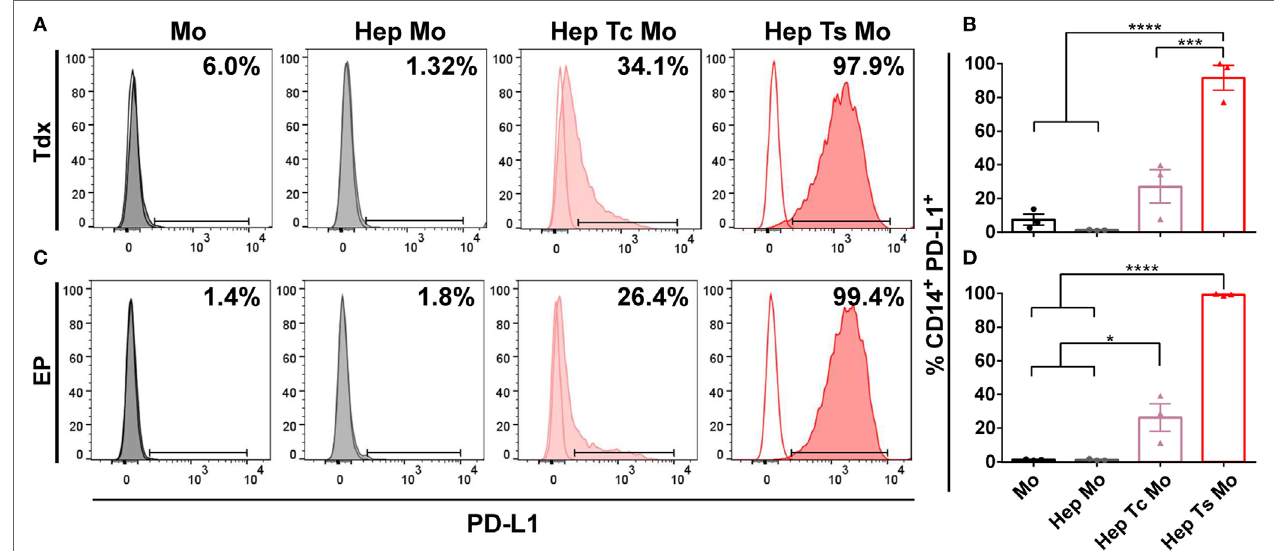
FigUre 3 | (a,c) Representative histograms of the flow cytometry data of CD14 + PD-L1 + monocytes for co-cultures with either Tdx (a) or EP (c) HBV-specific TCR T cells at 24 h are shown. Tinted and non-tinted histograms, respectively, represent the stained sample or matched isotype control, where a horizontal line is drawn based on the isotype control to demarcate for PD-L1 + cells. Percentage values of CD14 + PD-L1 + cells are indicated. (B,D) Bar plots show the mean ± SEM of PD-L1 + monocytes for co-cultures involving Tdx (B) or EP (D) HBV-specific TCR T cells; bars are drawn where a comparison was made with * P ≤ 0.05, *** P ≤ 0.001, and **** P ≤ 0.0001. Statistical significance was evaluated by a one-way ANOVA with Holm-Sidak’s multiple comparisons test. EP, mRNA-electroporated; HBV, hepatitis B virus; Hep, HepG2-preS1-GFP; Mo, monocyte; Tc, control T cell; TCR T cells, T cell receptor-redirected T cells; Tdx, transduced; Ts, HBV-specific T